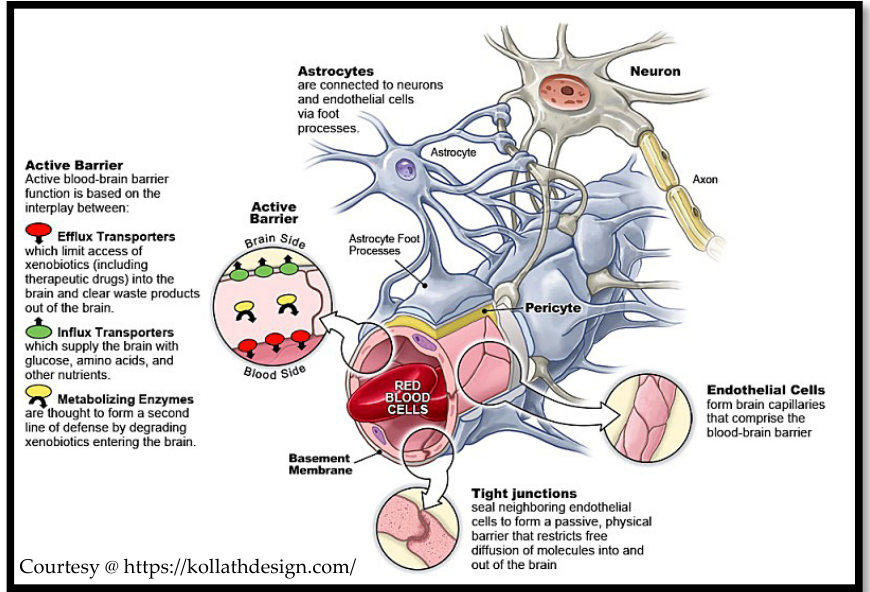
Figure 4. Replicating the dynamic barrier. A cross sectional view of the neurovascular unit that constitutes the BBB. Graphic courtesy of Mr. Richard Kollath (accessed on 29 April 2021).